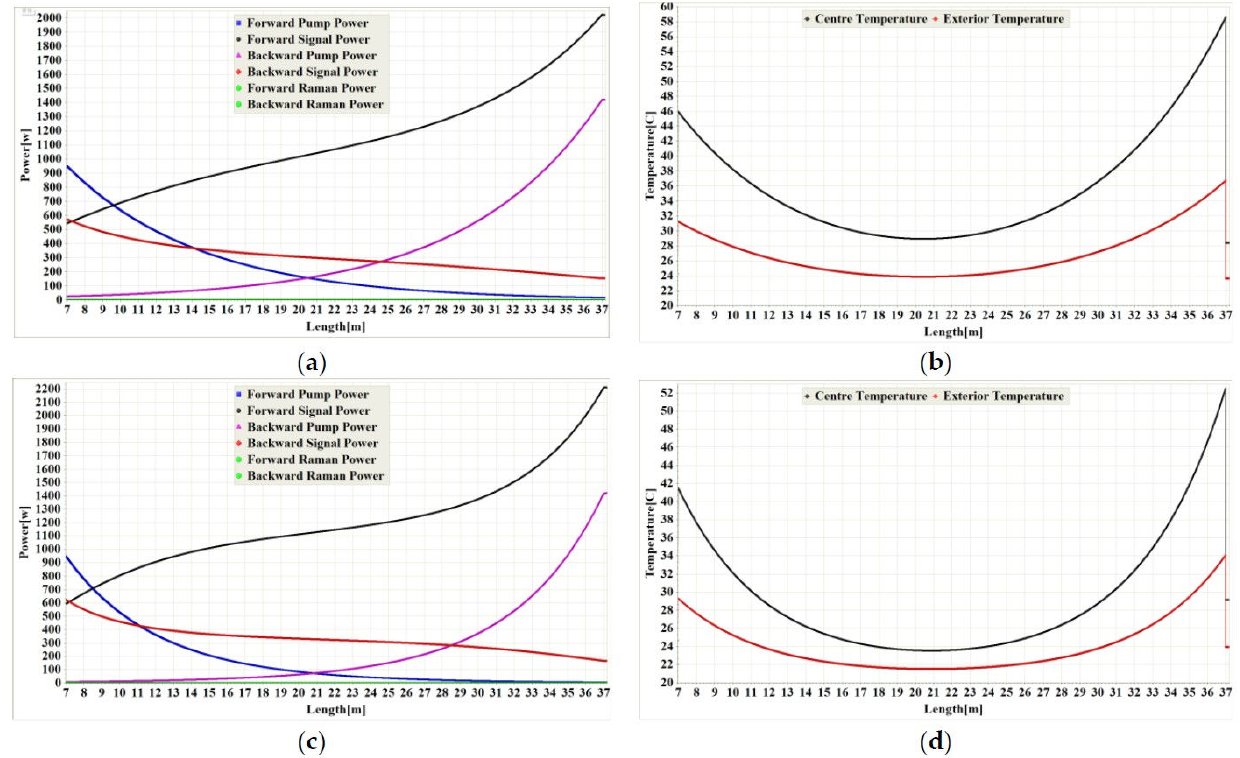
Figure 5. Numerical simulation results. ( a ) Power distribution with fiber length of the oscillator pumped by 915 nm LDs. ( b ) Temperature distribution with fiber length of the oscillator pumped by 915 nm LDs. ( c ) Power distribution with fiber length of the oscillator pumped by 981 nm LDs. ( d ) Temperature distribution with fiber length of the oscillator pumped by 981 nm